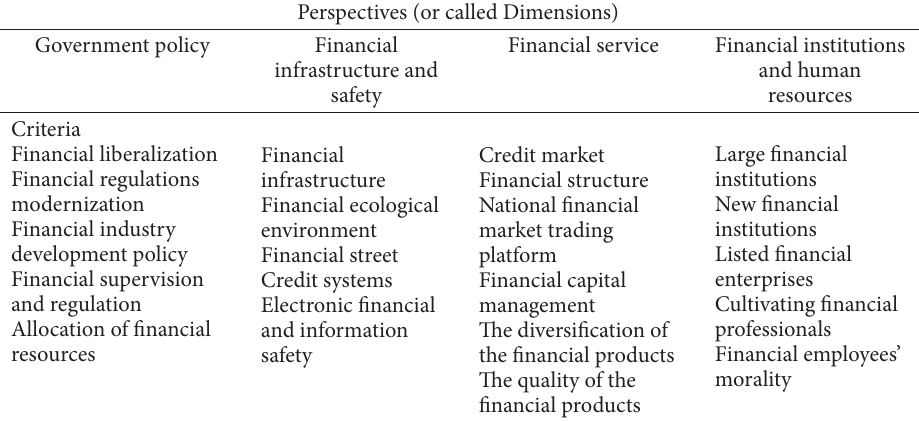
Table 1. The performance evaluation factors for the pre-test questionnaire Perspectives (or called